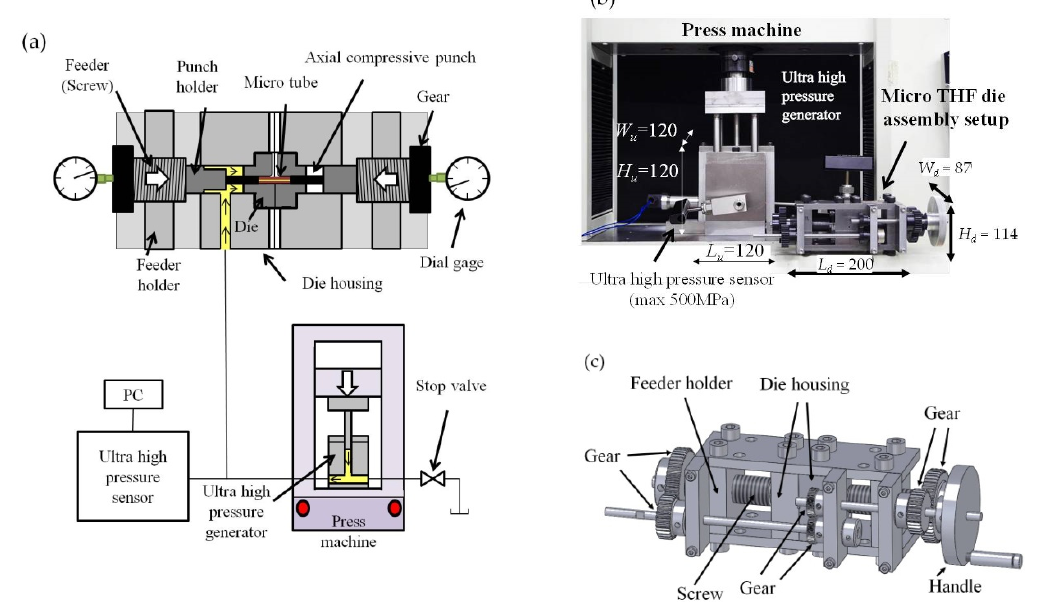
Figure 1. Microtube hydroforming (MTHF) system used for T-shape forming: ( a ) schematic of MTFH system; ( b ) appearance of MTHF system; ( c ) axial feeding mechanism in MTHF